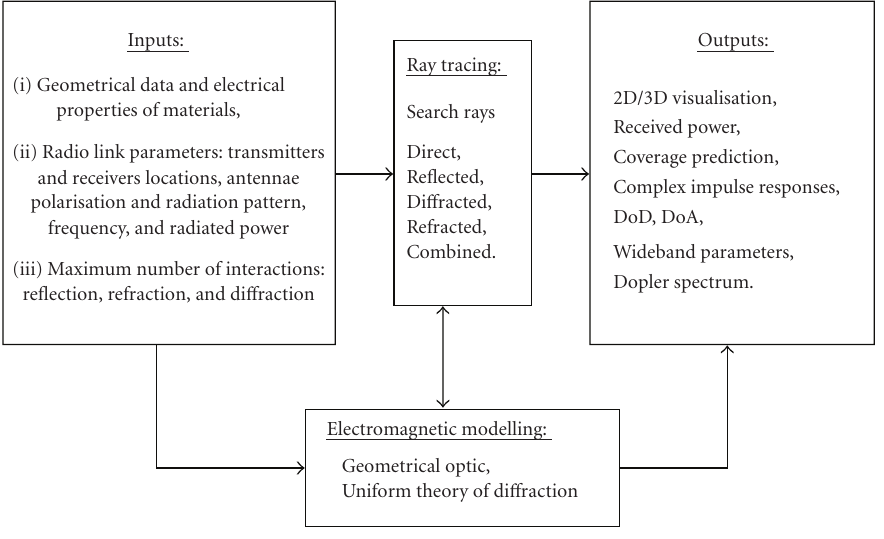
Figure 3: RAPSOR’s